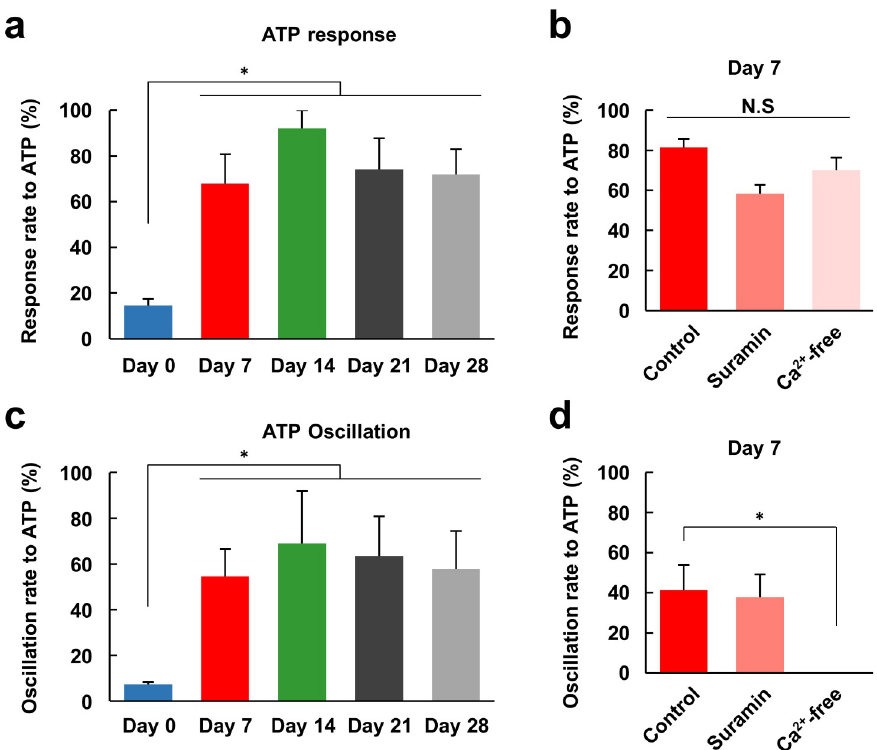
Fig 6. ATP-induced Ca 2+ oscillation requires extracellular Ca 2+ . Comparison of the average percentage of responding cells (response rate) (a) and the average percentage of cells exhibiting Ca 2+ oscillations (oscillation rate) (c) in response to ATP application in hDPSCs differentiated for the indicated days (n = 6, 5, 3, 3, or 2 cell populations for each condition, respectively). Response rate (b) and oscillation rate (d) upon ATP application in control conditions, in the presence of suramin (500 μ M) or in Ca 2+ -free conditions for hDPSCs differentiated for seven days (n = 6, 3, or 3 cell populations for each condition, respectively). Error bars, standard error of the mean. � P < 0.05 compared to Day 0 or